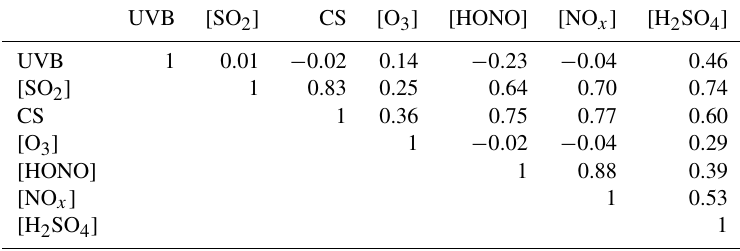
Table 2. Correlation coefficients (Spearman type) between [H 2 SO 4 ] and atmospheric variables during the daytime. UVB [SO 2 ] CS